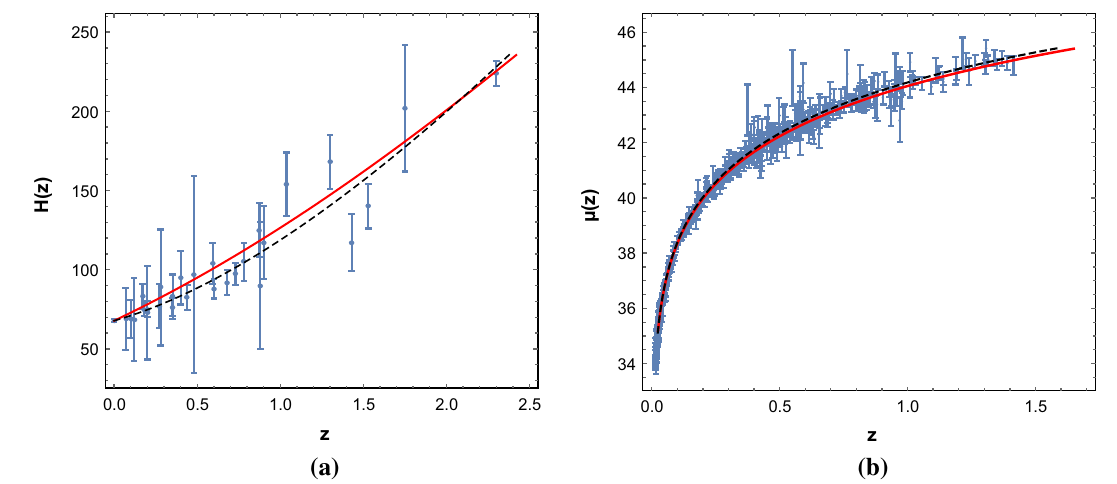
Fig. 9 Figures a and SNeIa show the comparison of our model and the (cid:3) CDM model with error bar plots of the Hubble data set and SNeIa Union 2.1 compilation data set, respectively. Red lines indicate our model and dashed black lines indicate the (cid:3) CDM model in both plots